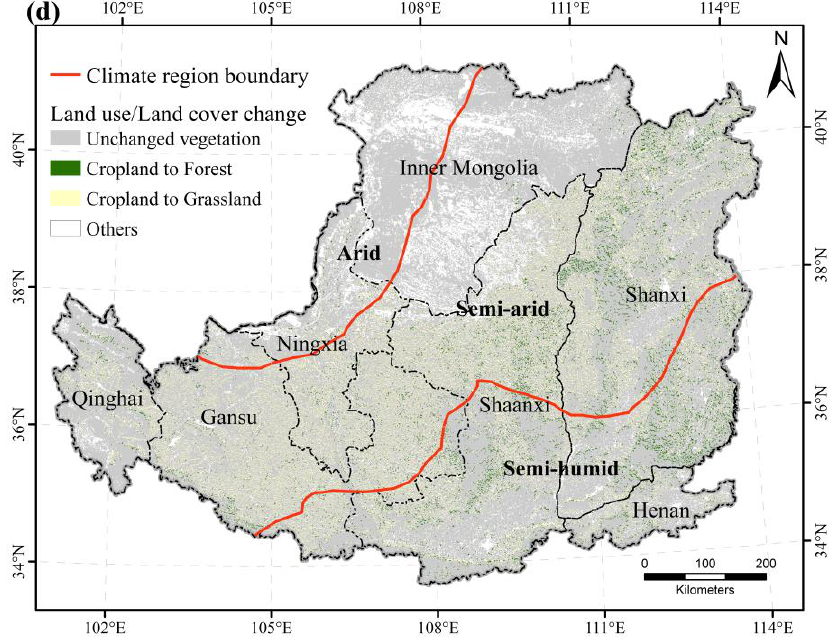
Figure 1. The spatial distribution of topography ( a ), climate zones ( b ), vegetation biotypes ( c ), and land use/land cover change ( d ) over the LP. The climate zoning is extracted from Zheng et al. [31]. The type of vegetation comes from the vegetation map of the People’s Republic of China (1:1,000,000) [32].